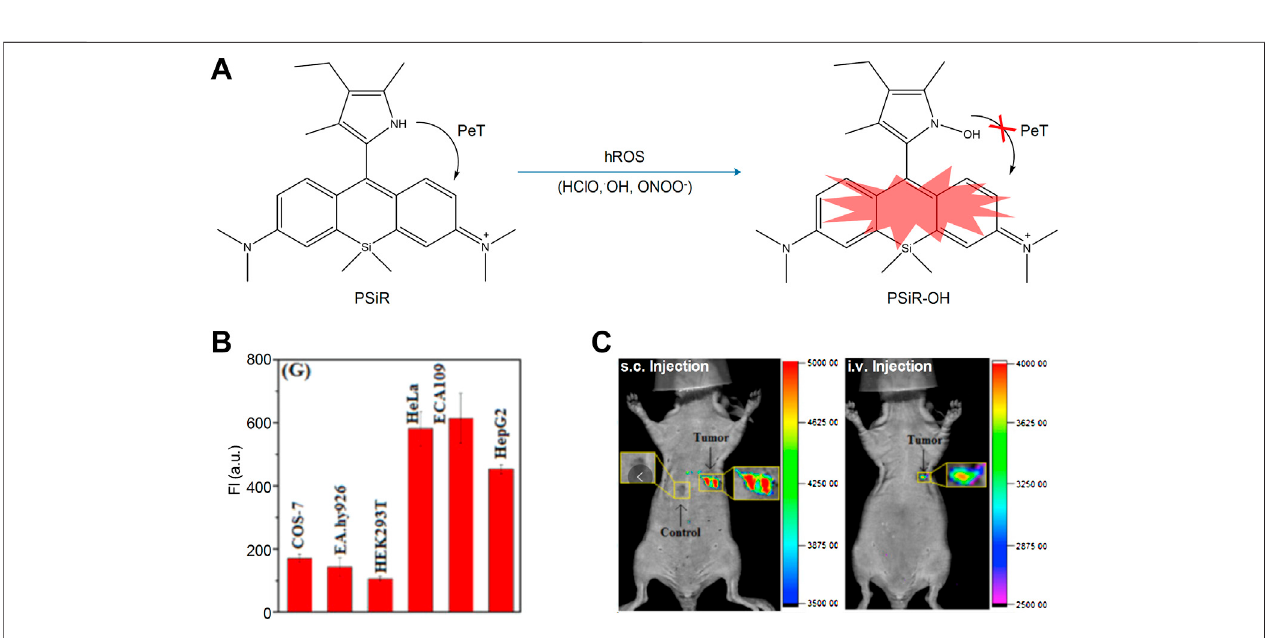
FIGURE 8 | The sensing mechanisms of PSiR for hROS and imaging characterization (Zhang et al., 2017). (A) The sensing mechanisms of PSiR for hROS. (B) Average fl uorescence intensity from images in various cells. (C) Imaging tumor using PSiR in tumor-bearing mouse with HeLa cells.